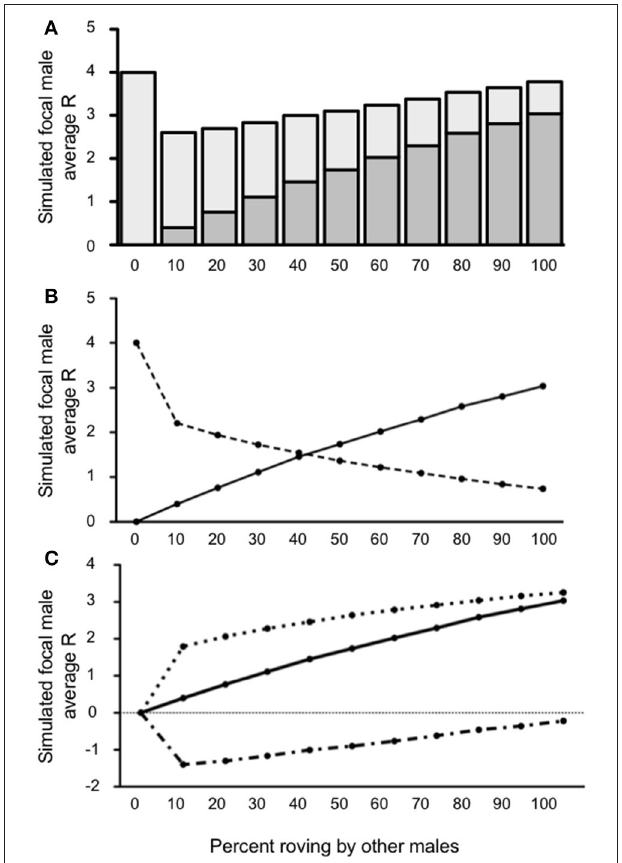
FIGURE 5 | Reproductive success for simulated roving focal male in Condition 2 at pair population 1,000 with 40% wandering. (A) Mean reproductive success (R) obtained by the simulated roving focal male at each percentage of roving in the population, split between R gained via extra-pair copulations (EPC; dark gray) and intra-pair copulations (IPC; light gray). (B) Average R gained via EPCs (solid line) and IPCs (dashed line) by the simulated roving focal male as the percentage of roving in the population increases. (C) Average R gained via EPCs ( E , solid line), average R lost via cuckolding ( C , dotted line), and total change in R ( 1 R, dash-dotted line) for the simulated roving focal male as the percentage of roving in the population increases. reproductive pay-off for the simulated focal male depending on the proportion of other males that decided to rove.